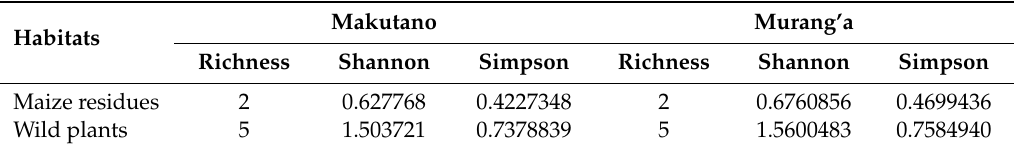
Table 3. The stemborer species diversity ranking in maize residue and wild plant habitats during non-cropping seasons in two di ff erent localities in the central region of